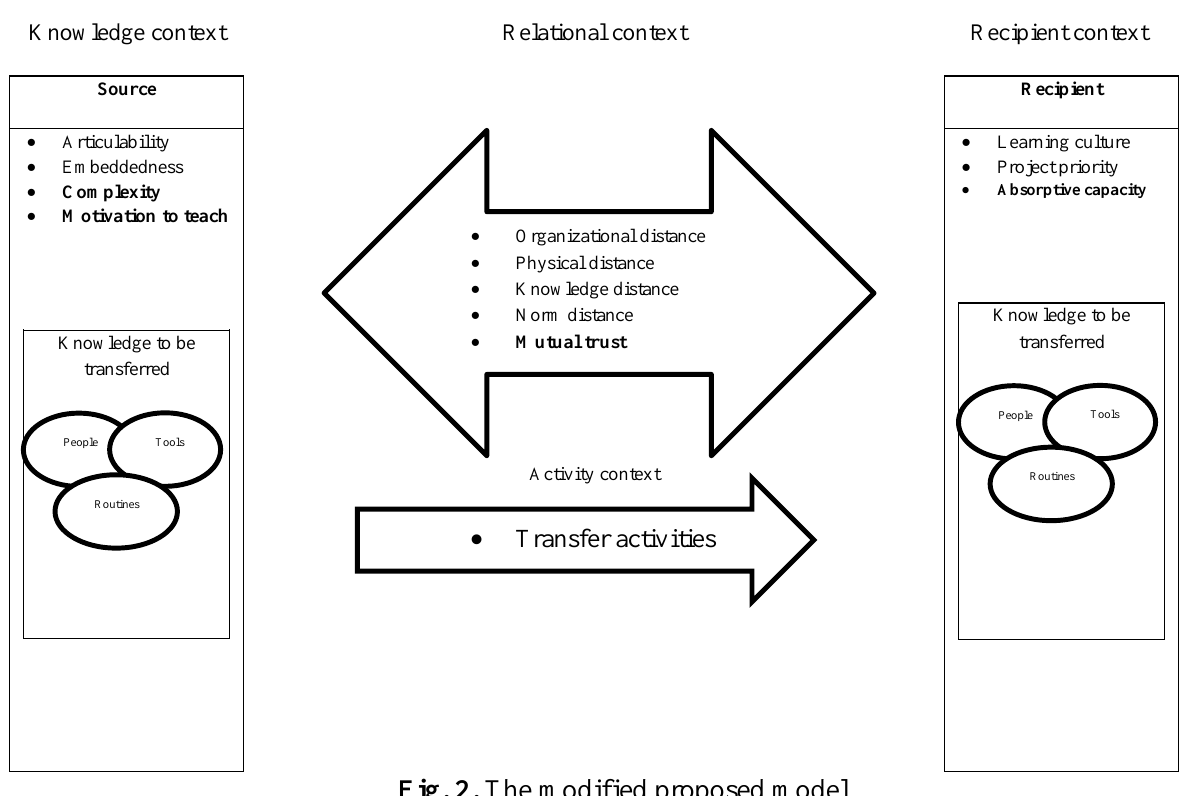
Fig. 2. The modified proposed model